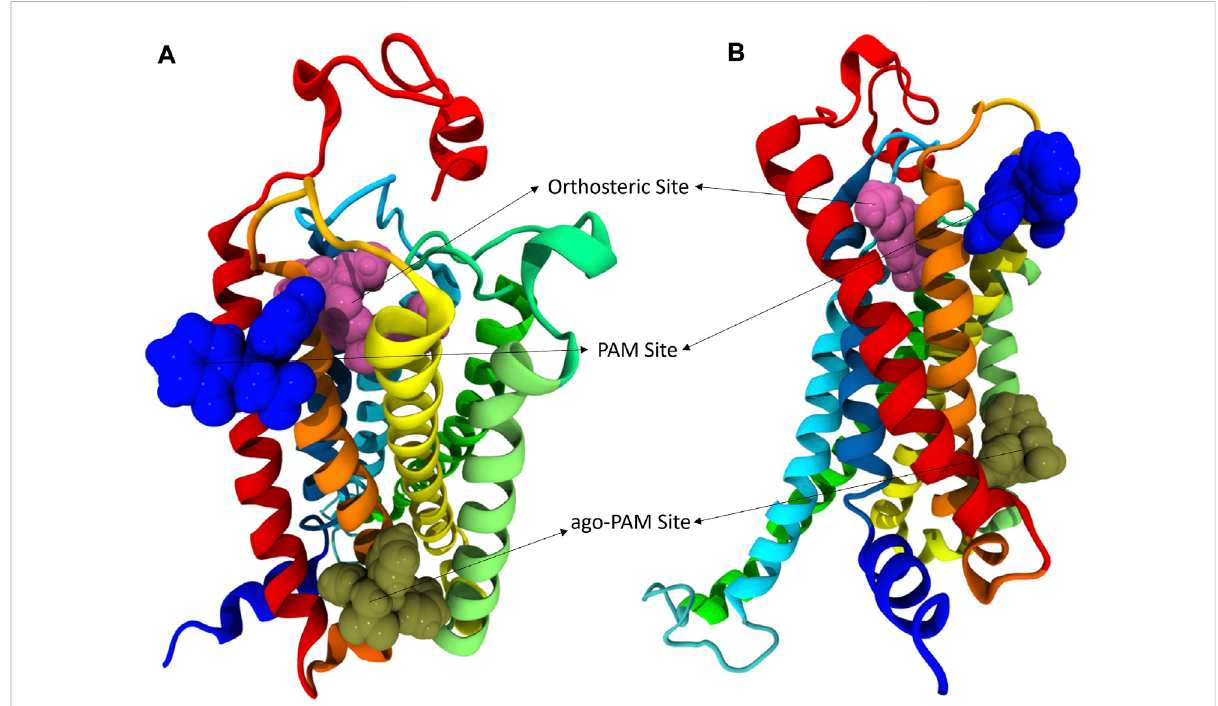
FIGURE 6 hCB1R with three different binding sites shown. In these views of hCB1R the orthosteric site is shown in magenta, an identi fi edPAM site in blue, and another identi fi ed putative ago-PAM site in tan. Transmembrane helices are: I red, II orange, III yellow, IV light green, V green, VI cyan, and VII blue. (A) is a visualization of CB1R looking down on the extracellular surface. (B) is a visualization of CB1R looking across at the transmembrane domains.